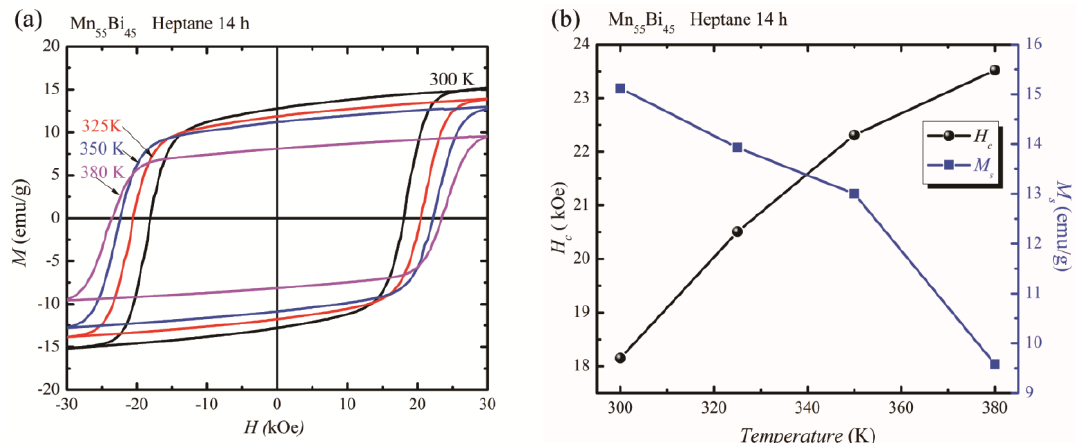
Figure 8. ( a ) Hysteresis loops at 300 K, 325 K, 350 K, 380 K and ( b ) Variation of coercivity, M s with temperature of Mn 55 Bi 45 powders obtained by LEBM for 14 h.